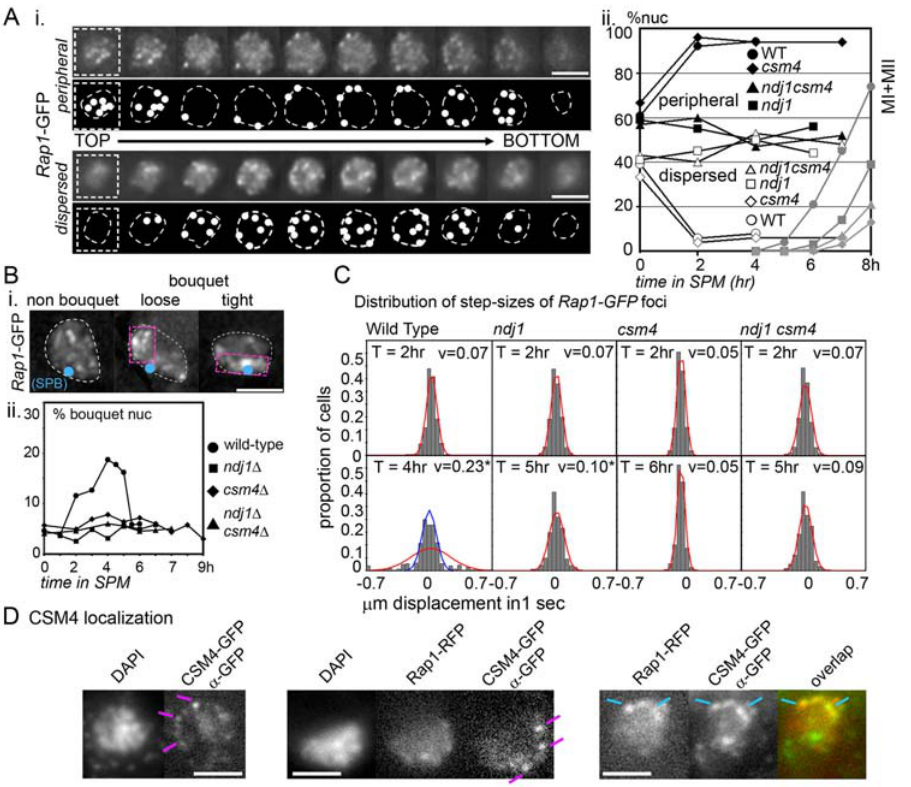
Figure 2. Telomere organization and dynamics in WT, ndj1 D , and csm4 D mutants. A) Telomere organization in strains whose telomeres are illuminated by Rap1-GFP. i Telomere organization in fixed prophase nuclei. Nuclei were distributed into two classes, ‘‘peripheral’’ (top panel; 10 frames from top to bottom) and ‘‘dispersed’’ (bottom panel) depending on the absence or presence of distinguishable Rap1-GFP foci within the nuclear volume, respectively (Materials and Methods). ii The proportions of these two categories (left Y axis) in WT (NKY4000) and ndj1 D , csm4 D , and ndj1 D csm4 D backgrounds (NKY3906, NKY3904, and NKY3905, respectively) were plotted as a function of time in sporulation media (SPM), with full and empty symbols on black lines corresponding to peripheral and dispersed proportions, respectively (Note: the differences between the two categories, while not absolute, is sufficiently robust that an untrained observer can place nearly all nuclei ( . 90%) in one category or the other without ambiguity. This robustness is further supported by the regular progression of changes in disposition over time not only in WT but also in mutants (below). The right Y axis and gray lines indicate the percentage of cells that have completed at least MI. B) Analysis of ‘‘bouquet’’ distribution in fixed nuclei. i 2D projections from 3D acquisition of Rap1-GFP signals, with the position of the SPB indicated by a blue circle (Materials and Methods). The nuclei presented here display peripherally localized telomere signals with either no evidence of bouquet colocalization or with ‘‘loose’’ and ‘‘tight’’ colocalization in the vicinity of the SPB. The region where most Rap1 foci co-localize is framed by a pink dotted rectangle. White dotted line indicates the outline of the nucleus, as estimated from Rap1-GFP background. Complete sets of 3D Rap1-GFP images and definitions of the three categories are provided in Figure S1. ii Proportion over time of nuclei exhibiting a ‘‘bouquet’’ configuration in WT, ndj1 D , csm4 D , and ndj1 D csm4 D backgrounds (NKY4000, NKY3906, NKY3904, and NKY3905, respectively; , 100 nuclei per timepoint). C) Chromosome motion during prophase. i For statistical convenience, the histograms of the x and y step-sizes of Rap1-GFP foci, recorded every second over 1 min, were plotted prior to zygotene (t=2 h for WT and ndj1 D /csm4 D mutants, respectively), and during zygotene stages (t=4, 5, 6, and 5 h for WT, ndj1 D , csm4 D , and ndj1 D csm4 D backgrounds, respectively; Materials and Methods). Red curves indicate the distribution expected when assuming that the displacements follow a Normal distribution. For WT t=4 h, the blue curve represent the expected Normal distribution of the step sizes included within v (t=2 h) 6 2 S.D. (i.e. 77% of total measurements). v indicates the mean velocity of telomeric 2D displacements over time. An accompanying asterisk indicates a statistically significant difference in velocity the between pre-zygotene and zygotene stages (t-test, 0.05 significance level; Material and Methods). D) Csm4 localization in WT cells expressing Rap1-RFP and GFP-Csm4 (EAY1797). Fixed cells were spread and hybridized with anti-GFP antibodies. Pink and turquoise lines outline the nuclear peripheral Csm4 signal and co-localization of Rap1 and Csm4 signals, respectively. All scale bars represent 2 m m. doi:10.1371/journal.pgen.1000188.g002 Rap1 foci taken from a minimum of 5 different nuclei (yielding a t =4 h, foci exhibit an increased average velocity of total of 340 one-second step-sizes for both time points). At t = 2 h, 0.23 6 0.23 m m/sec, in accord with earlier studies [5,6]. Moreover when telomeres have reached their peripheral localization, the step-sizes no longer fit a Gaussian distribution (Figure 2C, red average velocity of movement (v) through two-dimensional space curve); instead, there appear to be two types of movement, with a was 0.07 6 0.05 (S.D.) m m/sec. Further, these step sizes exhibit majority of steps being smaller and corresponding to a near- nearly (but not perfectly) a Gaussian distribution, suggesting that Gaussian distribution (Figure 2C, blue curve; , 77% of total) plus all foci are behaving similarly (Figure 2C, red curve; for details see a minority of much larger steps. The two apparent subpopulations figure legend and Materials and Methods). The same features are exhibit velocities of , 0.1 and , 0.45 m m/sec, respectively, both of also seen previously at t= 0 h (average velocity 0.06 6 0.05 m m/sec which are greater than the velocity observed at t= 2 h with a near-Gaussian step-size distribution), in accord with the fact ( , 0.07 m m/sec). The existence of two such populations is in good that active motion has not yet begun by t = 2 h [6]. In contrast, at agreement with the fact that, during the period of active actin-